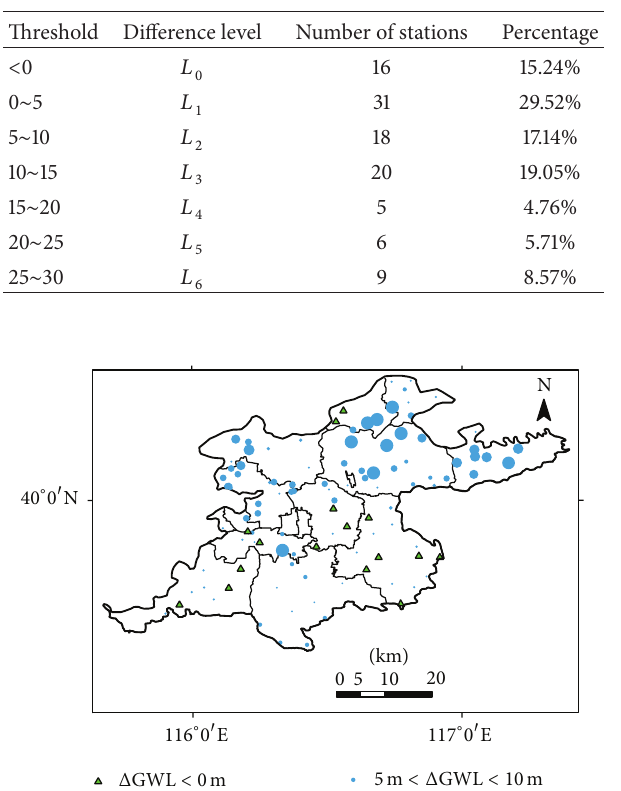
Table 3: Variation of groundwater level at monitoring station.